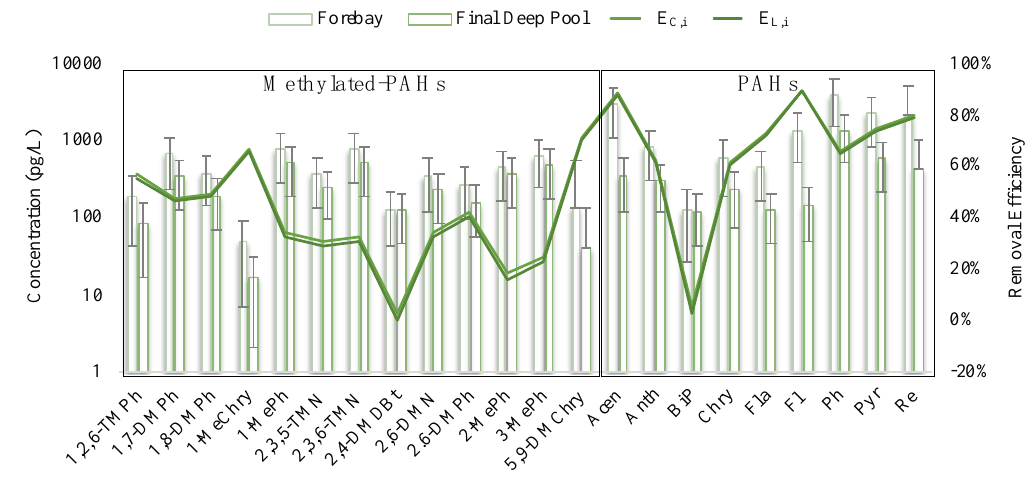
Figure 4. Dissolved aqueous concentrations and removal e ffi ciencies of PAHs in the Kearl Treatment Wetland during deployment three (2018). Error bars represents standard errors of the mean.